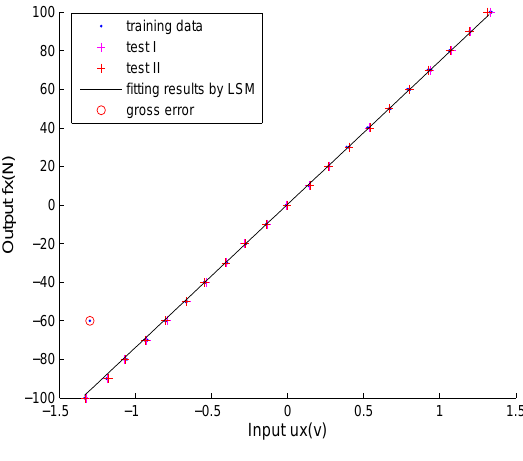
for calibration data with gross error. x